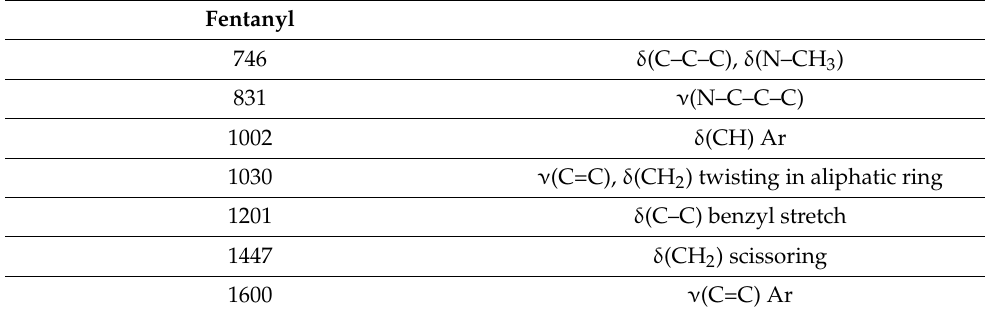
Table A1. Characteristic vibrations of